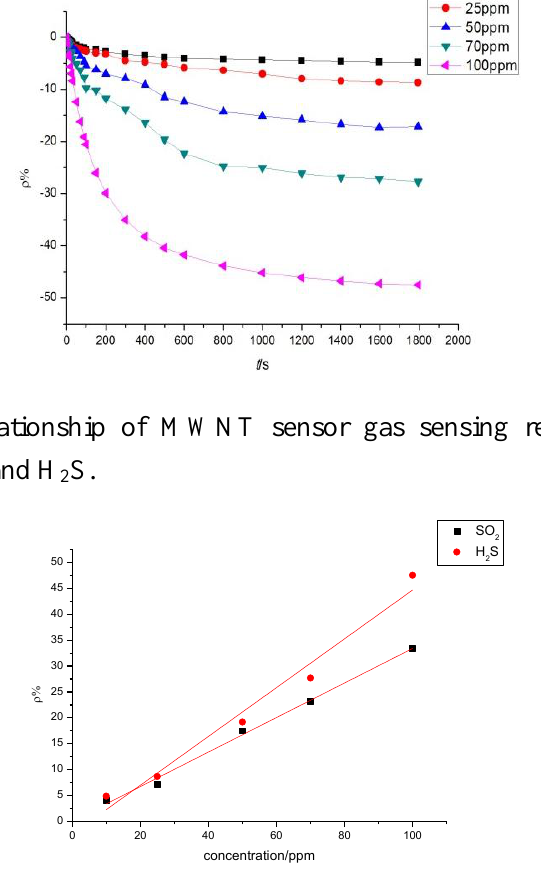
Figure 10. MWNT sensor response to different concentrations of H